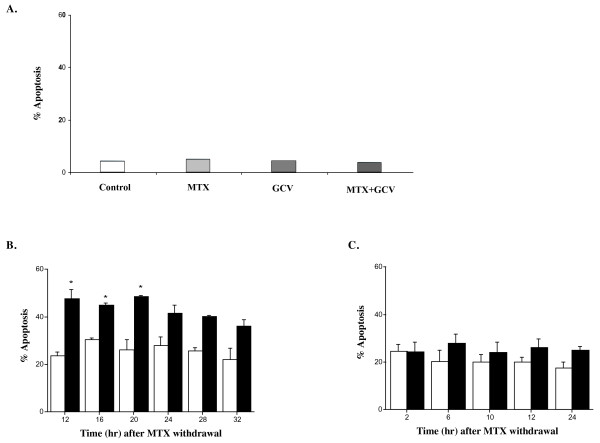
Induction of apoptosis. Untransduced DHDK12 cells (A) were treated with MTX, GCV or the combination of MTX plus GCV for 24 h. Transduced DHDK12 cells (B) and transduced HT29 cells (C) were treated for 24 hr with (filled square) or without (open square) MTX. Cells were transduced with TG 9344 at the indicated times after MTX washout and 48 hr after transduction were treated with 20 μM GCV for 72 hr. Quantitative detection of apoptosis was determined by biparametric flow cytometry analysis of fluorescein labeled-annexin V cells and PI. Apoptotic cells were annexin V positive, PI negative. Data are expressed as the mean ± SE from at least three separate experiments. * P <.05 vs untreated cells